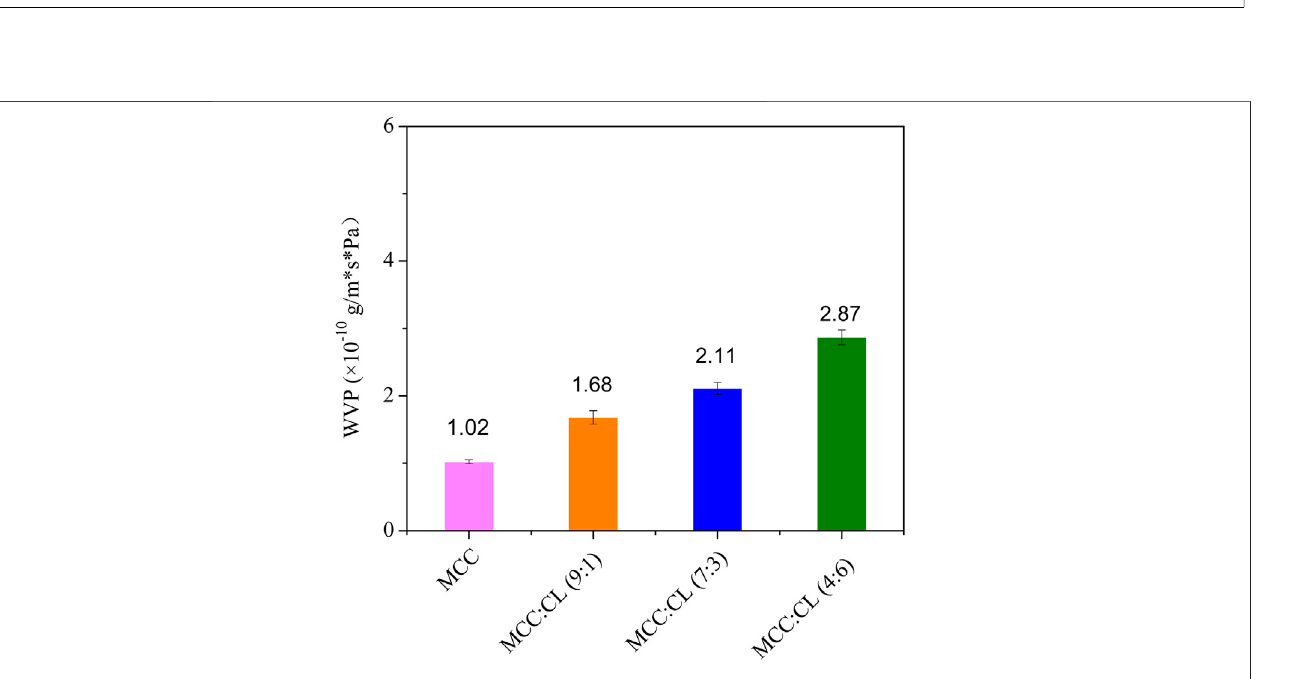
Frontiers in Bioengineering and Biotechnology |